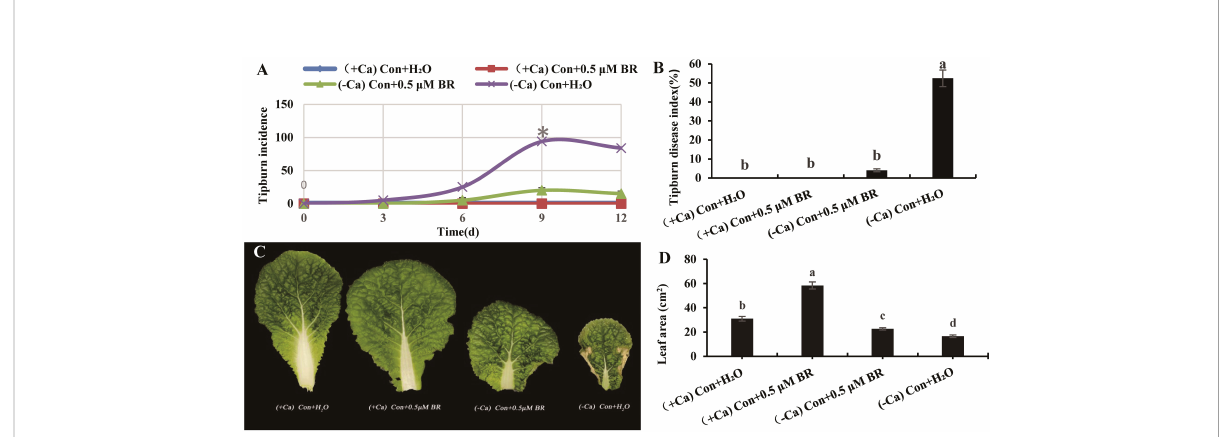
FIGURE 1 Effects of exogenous BRs on tip-burn incidence rate, disease index and leaf area of mini Chinese cabbage induced by Ca 2+ de fi ciency. (A) the incidence rate of tip-burn at 0, 3, 6, 9 and 12 d after treatment. (B) the disease index of tip-burn on 9th day; (C) the fourth functional leaf counted from inside to outside of mini Chinese Cabbage seedlings; (D) Leaf area. The different letters above the bars showed signi fi cantly different among treatments according to Duncan ’ s multiple test ( P <